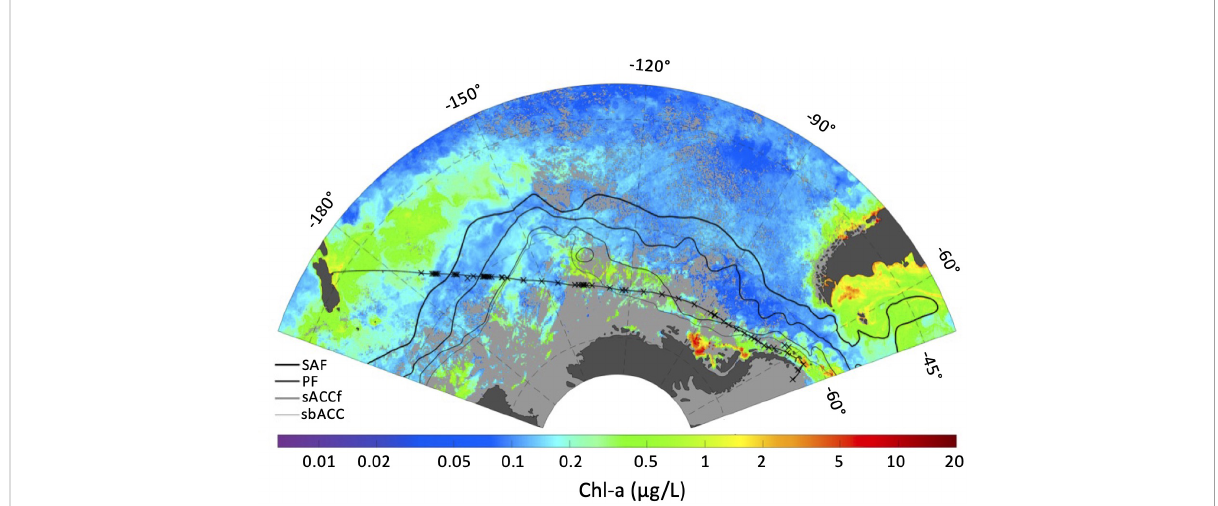
FIGURE 1 ANA08D 2018 expedition cruise track (thin black line linking New Zealand to the Antarctic Peninsula), sampling locations (x), and climatological front locations de fi ned by Orsi et al., 1995 (SAF, Sub-Antarctic front; PF, Polar front; sACCf, Southern Antarctic Circumpolar Current font; sbACC, Southern Boundary of the ACC) overlaid on a MODIS chlorophyll-a composite for March